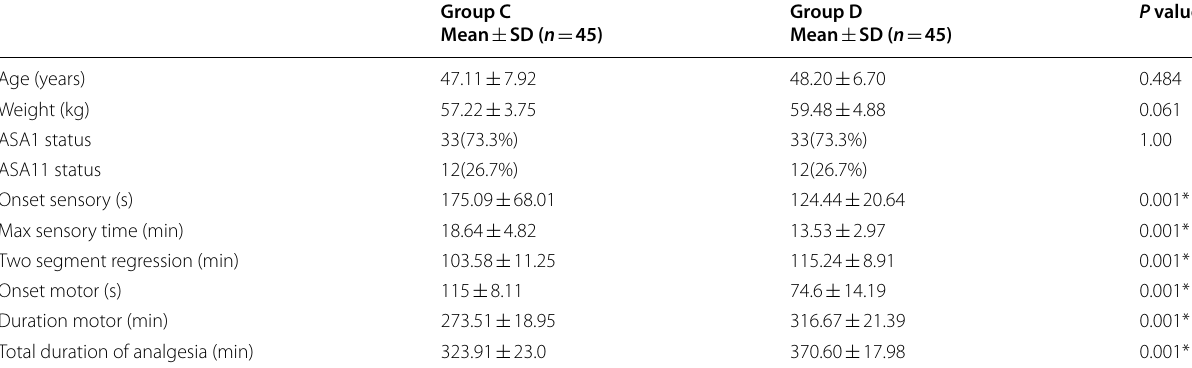
Table 1 Demographic profile and characteristics of block